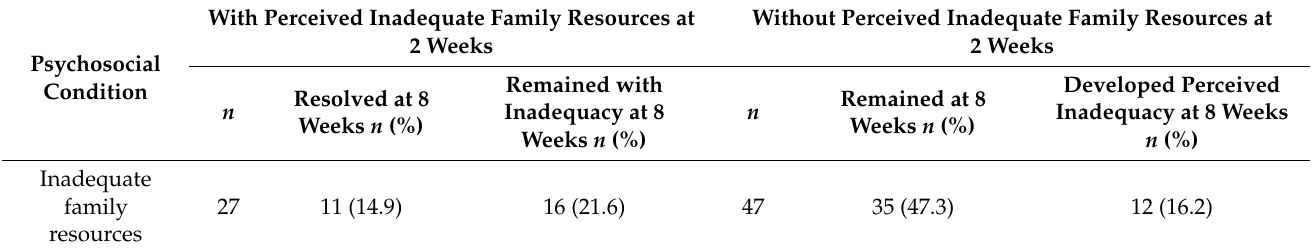
Table 7. Dynamics of perceived inadequacy of family resources among patients and family members at 2 and 8 weeks after discharge ( n = 74).